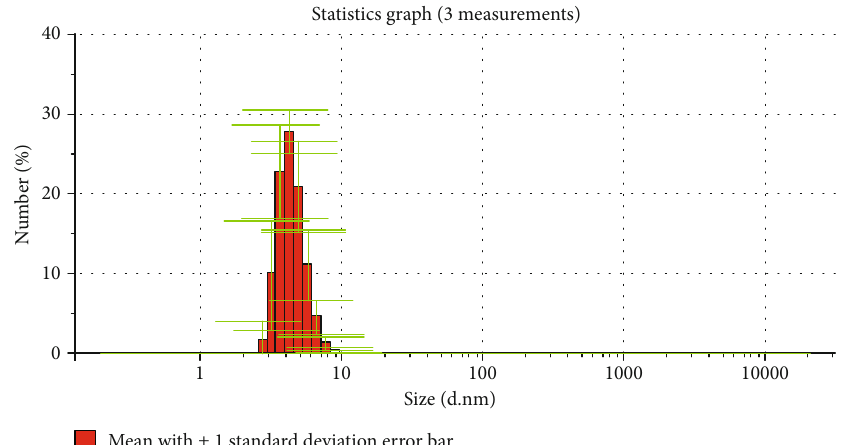
Figure 4: Particle size analysis of the cadmium sul fi de nanoparticles biosynthesized by Aspergillus niger (RCMB 002002). Malvern Instruments Ltd., serial number: MAL1071664, Zetasizer ver.